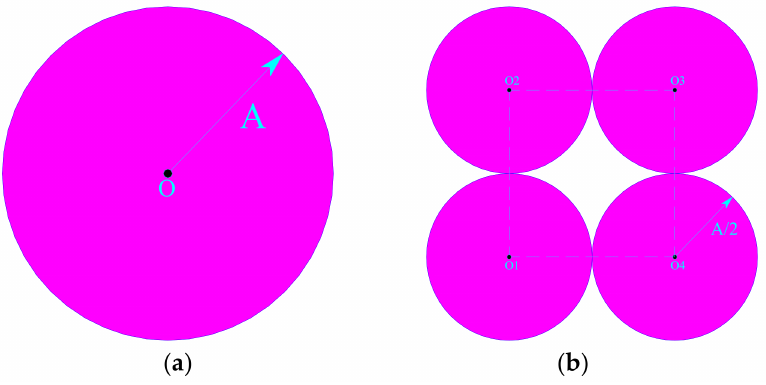
Figure 24. Mineral circles with the same area: ( a ) radius A, ( b ) radius